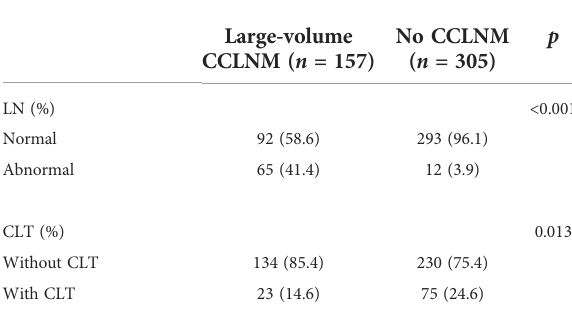
TABLE 1 Basic characteristics of